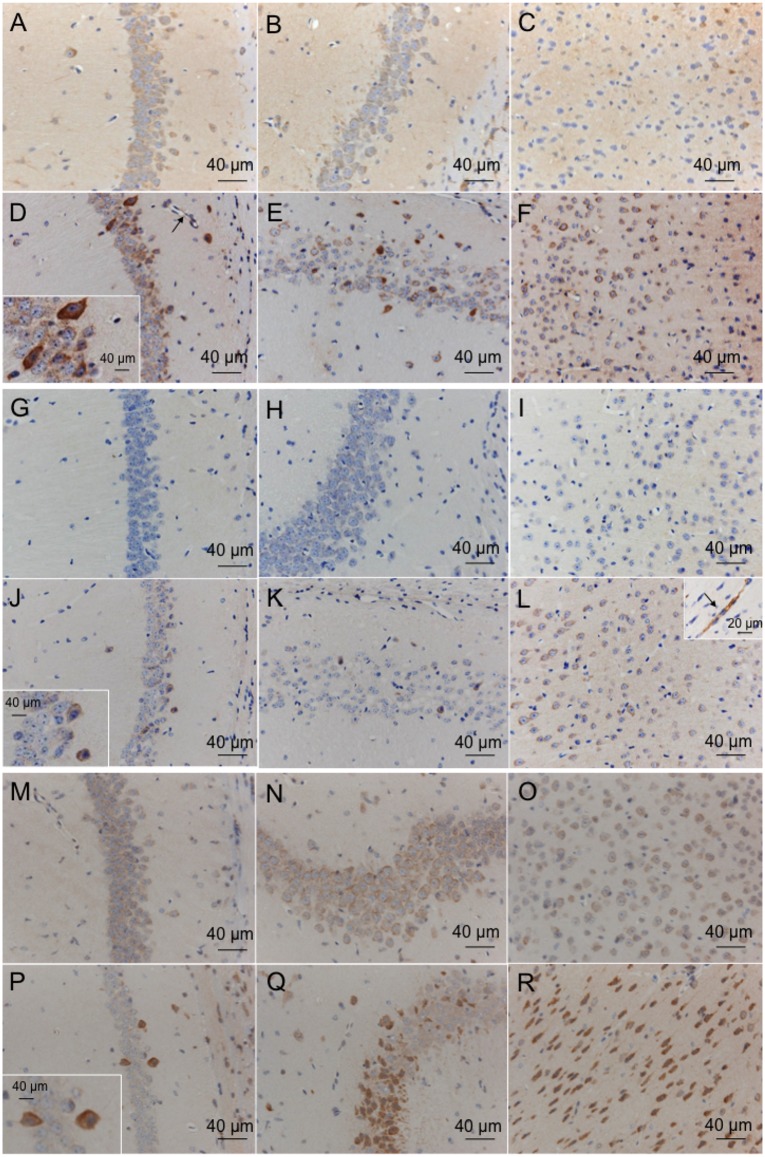
Distribution of immunoreactivity for 3-nitrotyrosine and 4-HNE in mice after global brain I/R injury.Sections were prepared from the CA1 (3-nitrotyrosine, A; 4-HNE, G; NF-κB, M), CA2 (3-nitrotyrosine, B; 4-HNE, H; NF-κB, N), and motor cortex (3-nitrotyrosine, C; 4-HNE, I; NF-κB, O) regions of the control brain and after 14 min of ischemia and 8 h of reperfusion in the CA1 (3-nitrotyrosine, D; 4-HNE, J; NF-κB, P), CA2 (3-nitrotyrosine, E; 4-HNE, K; NF-κB, Q) and motor cortex (3-nitrotyrosine, F; 4-HNE, L; NF-κB, R) regions of the brain. Arrow indicates vascular endothelium.